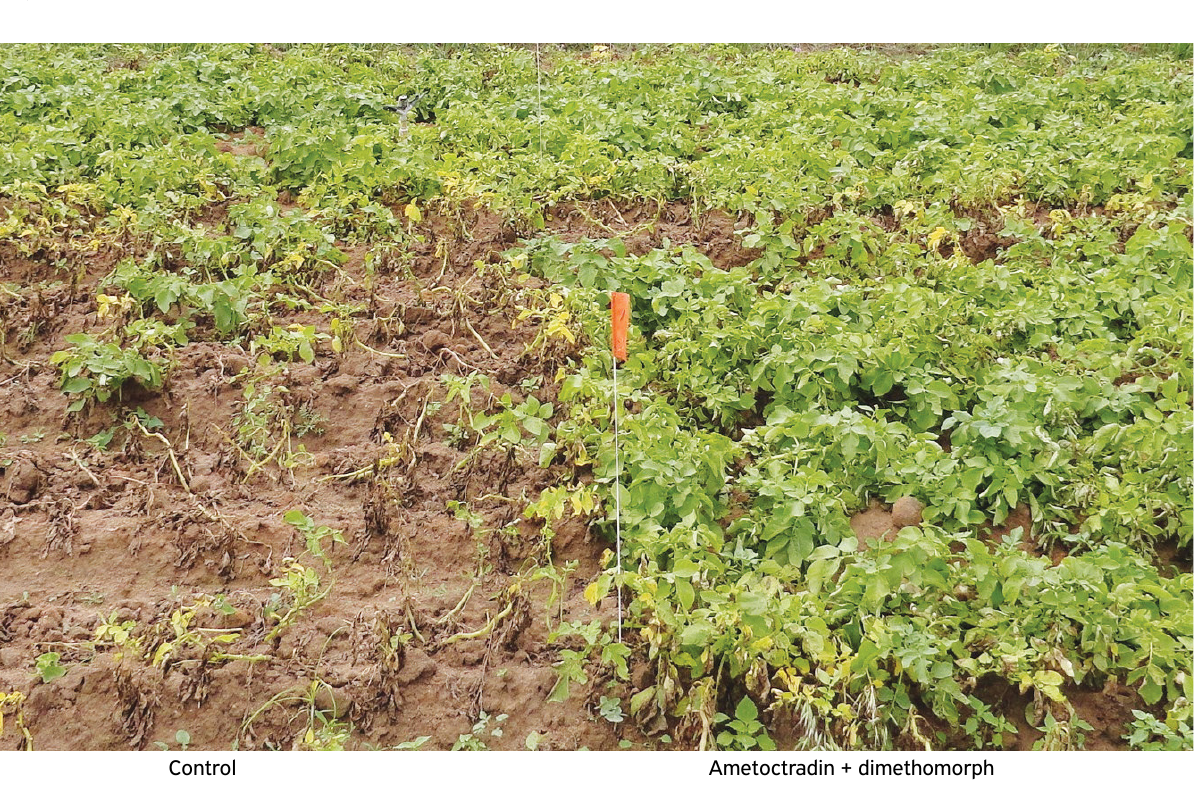
Figure 1. Severity of late blight in potato (Ágata cultivar) in plots not treated and treated with ametoctradin + dimethomorph (1.25 L.ha -1 ). Pilar do Sul, São Paulo, Brazil,